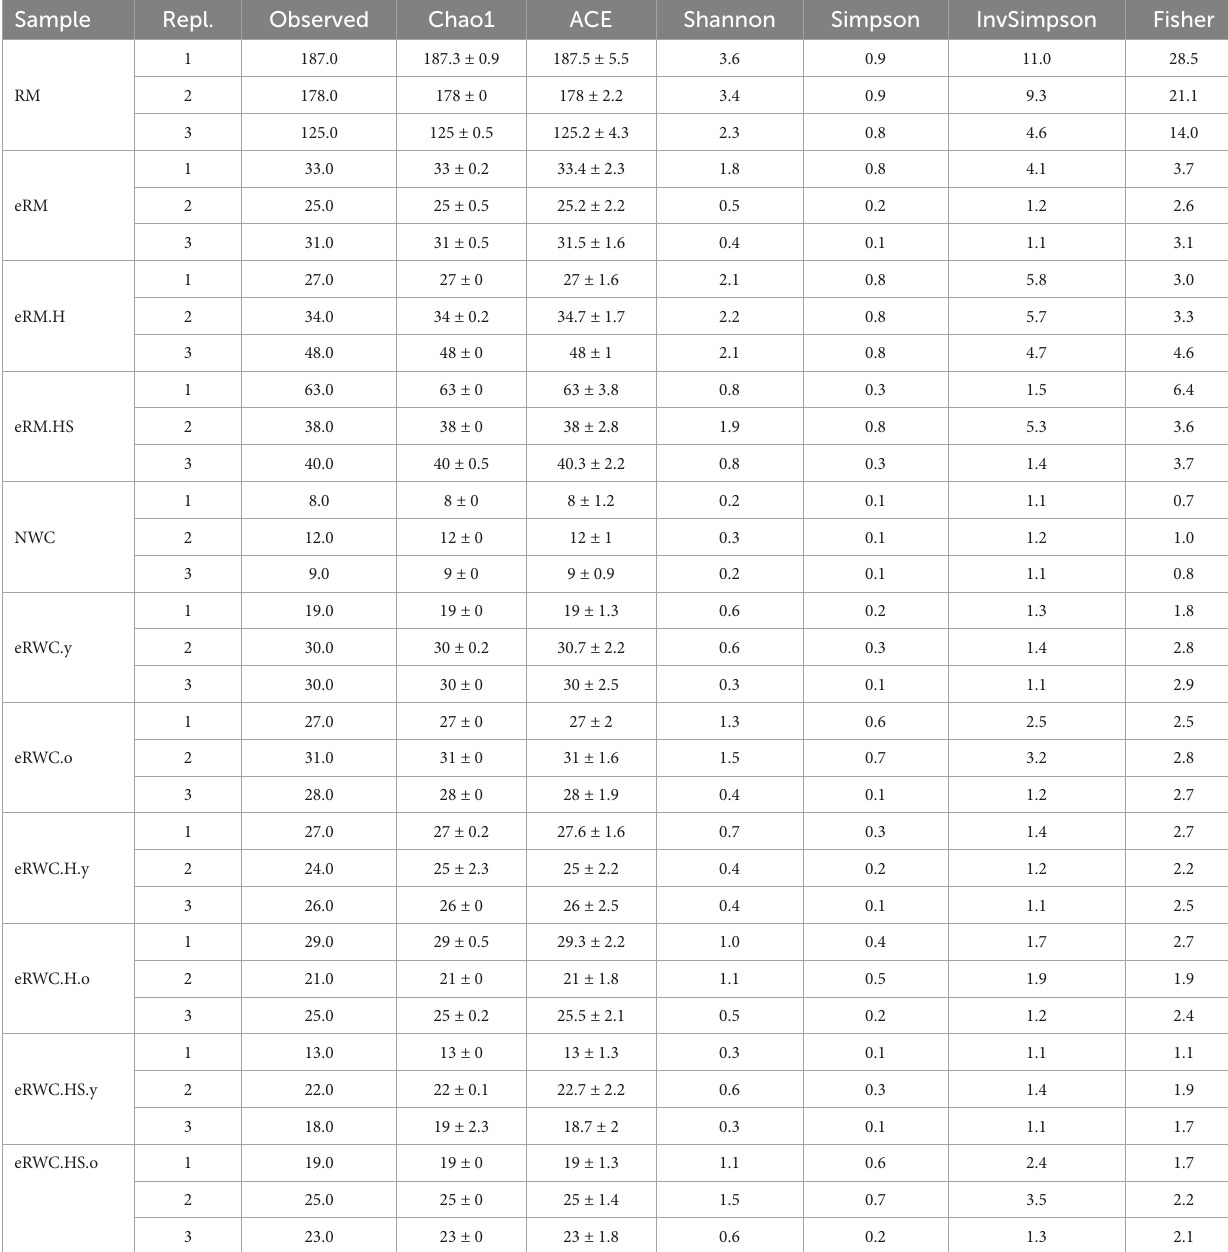
TABLE 3 Alpha diversity parameters of RM, eRMs, NWC, and eRWCs. Sample